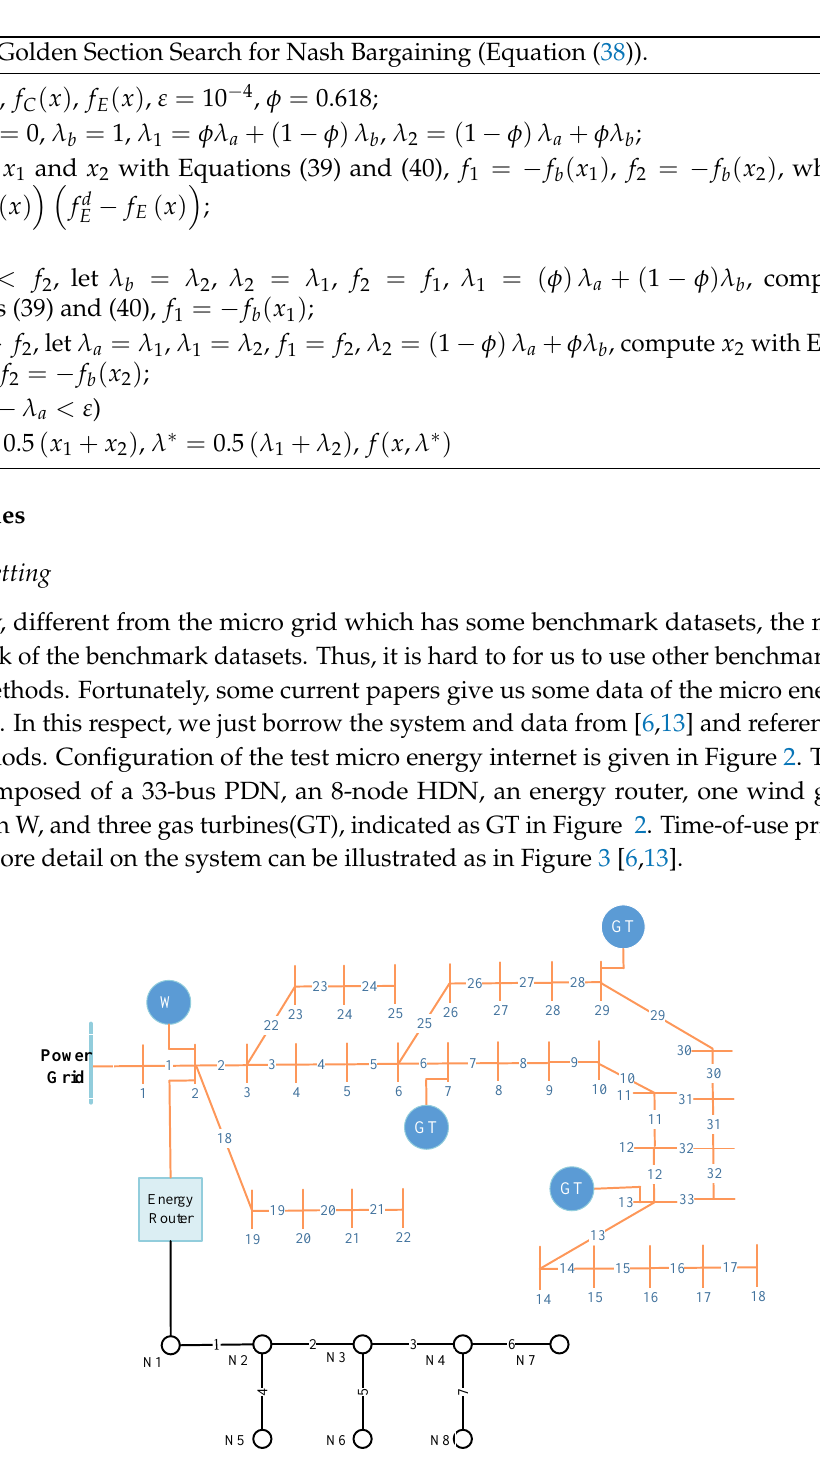
Figure 2. Configuration of the studied micro energy